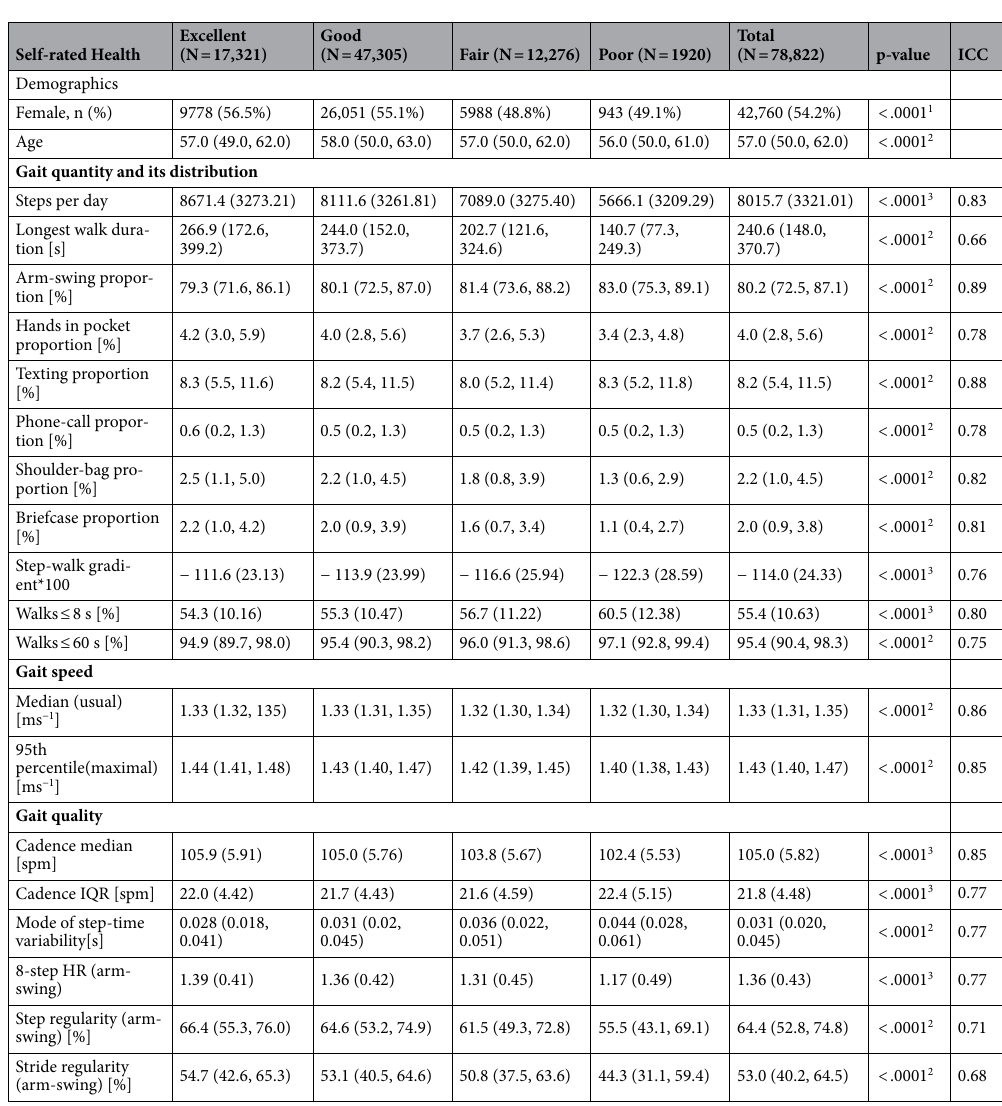
Table 3. Summary statistics and test–retest reliability of digital gait biomarkers (n = 78,822). HR harmonic ratio, ICC intraclass correlation, IQR interquartile range, ms − 1 m per second, s second, spm steps per minute. 1 Count and proportion with Chi-Square p-value. 2 Median and Inter-quartile range with Kruskal–Wallis p-value; 3 Mean and standard deviation with ANOVA F-test